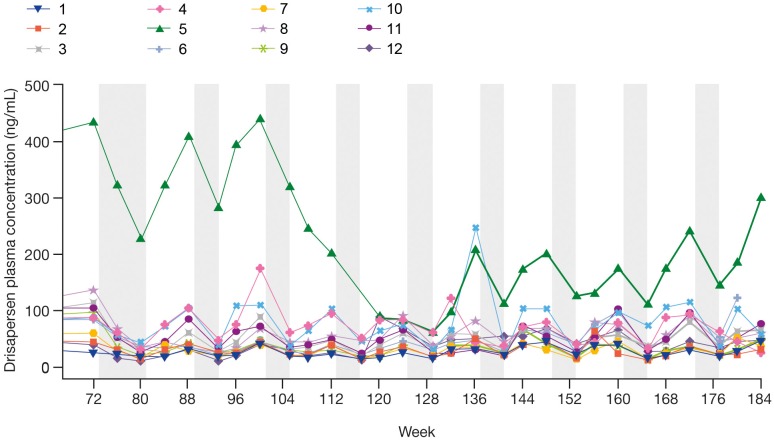
Individual drisapersen trough concentrations from weeks 72 to 184.Subject 5 had an additional treatment break from weeks 101 to 128 inclusive. Subjects 1, 2, 5, 6, 7, 9, and 12 walked ≥330 m at extension study baseline; subjects 3, 4, 8 10, and 11 walked <330 m at extension study baseline. Grey shading is representative of off-treatment periods.